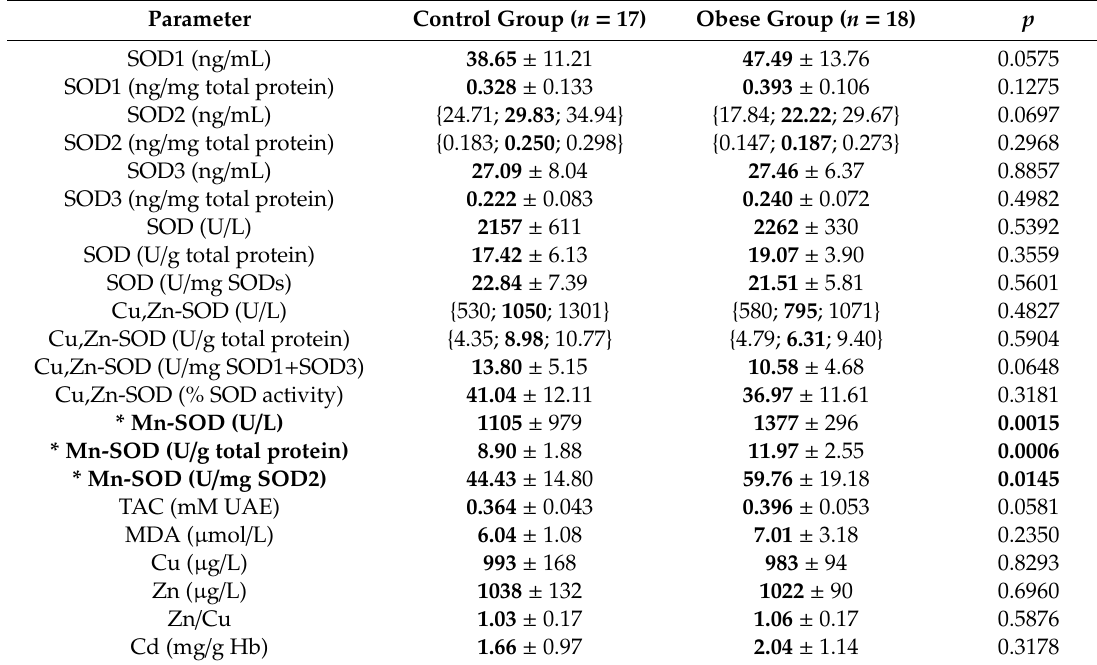
Table 3. Values of selected pro- and antioxidative parameters, and concentration of selected metals, in context of obesity, in men not exposed to cigarette smoke.